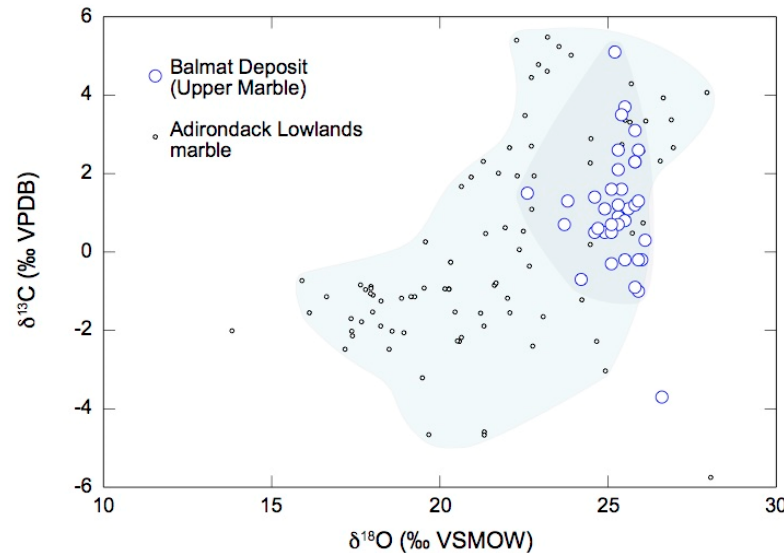
Figure 11. Oxygen and carbon isotopes of samples from the evaporitic Balmat zinc deposits [50] and and the Adirondack Lowlands the Adirondack Lowlands [36].